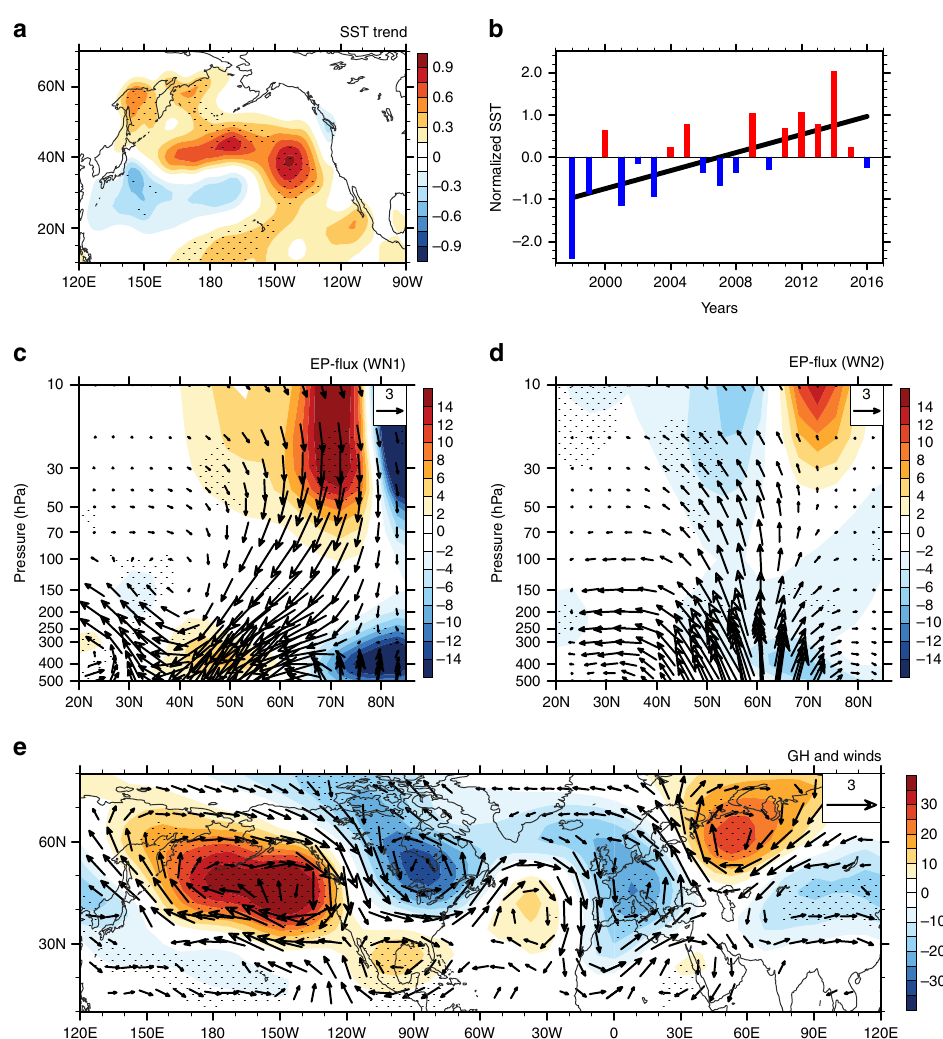
Fig. 4 Wave activity linked to the central North Paci fi c SST. Trends in the North Paci fi c SST (shading; units: K decade − 1 ) during boreal winter using the ERSST.v3b dataset from 1997/98 to 2015/16 ( a ). Time series of the normalized central North Paci fi c SST averaged over (35°N – 45°N, 150°E – 150°W; SST CNP ) ( b ). The straight black line represents the linear trend in the normalized time series of SST CNP . The Eliassen – Palm (EP) fl ux and its divergence with c wavenumber-1 and d wavenumber-2 components from MERRA regressed onto the normalized SST CNP in DJF during 1997/98 – 2015/16, respectively. e As in c and d , but for regressions of 500-hPa geopotential height anomalies (contours; units: 100 gpm) and winds (vectors; only values >0.5 m s − 1 are shown). Geopotential height trends in stippled areas are signi fi cant at/above the 95% con fi